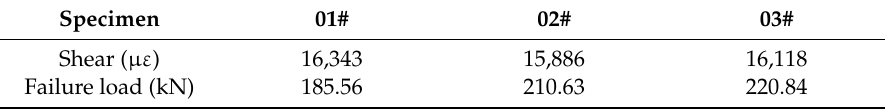
Table 3. Shear strain extremes on composite skins corresponding to failure